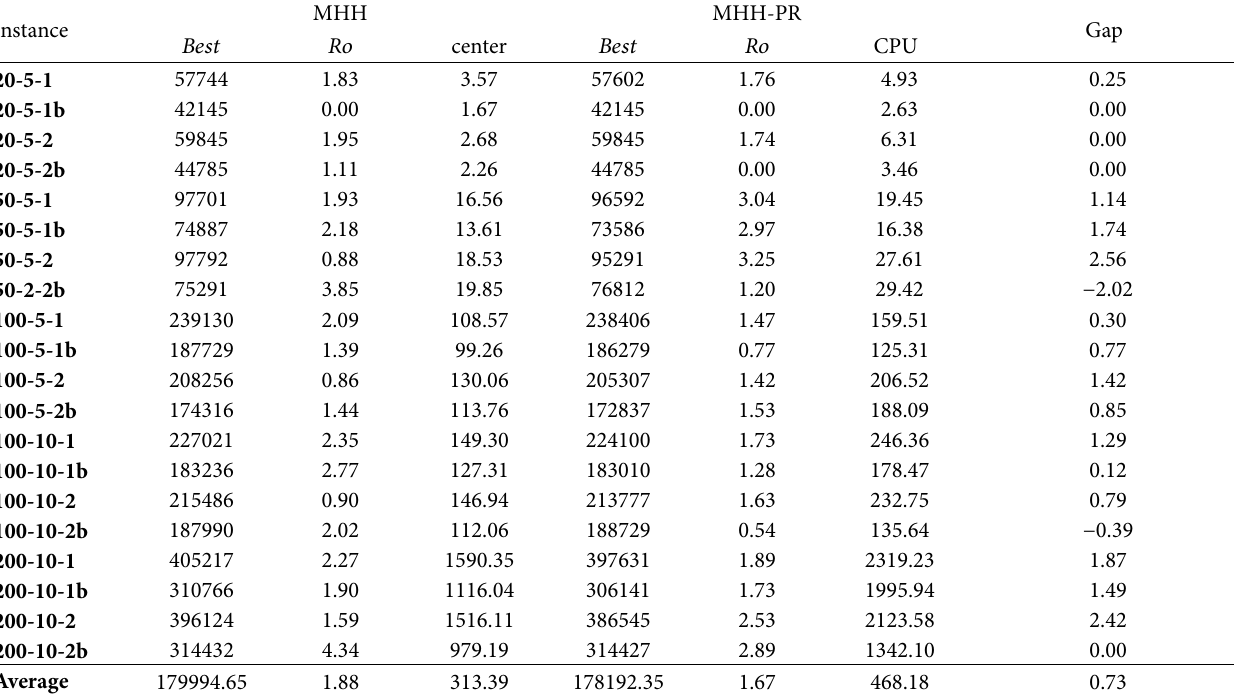
Table 6: Comparison of MHH and MHH-PR in 𝑌 -type 2E-LRPSPD